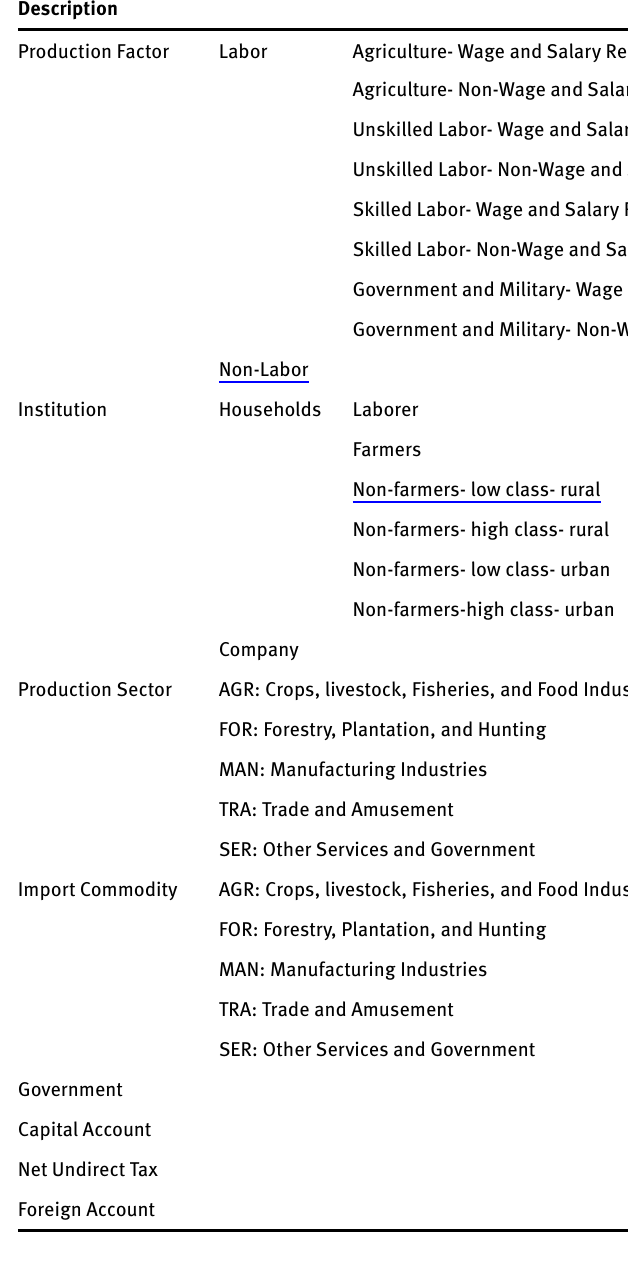
Table A2: SAM 36x36 classification after adjustment